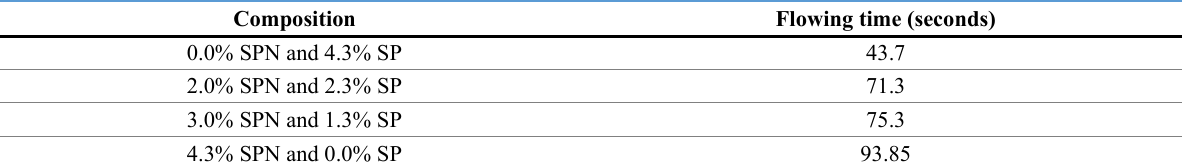
Table 2. Flowing time for different proportions of SP and